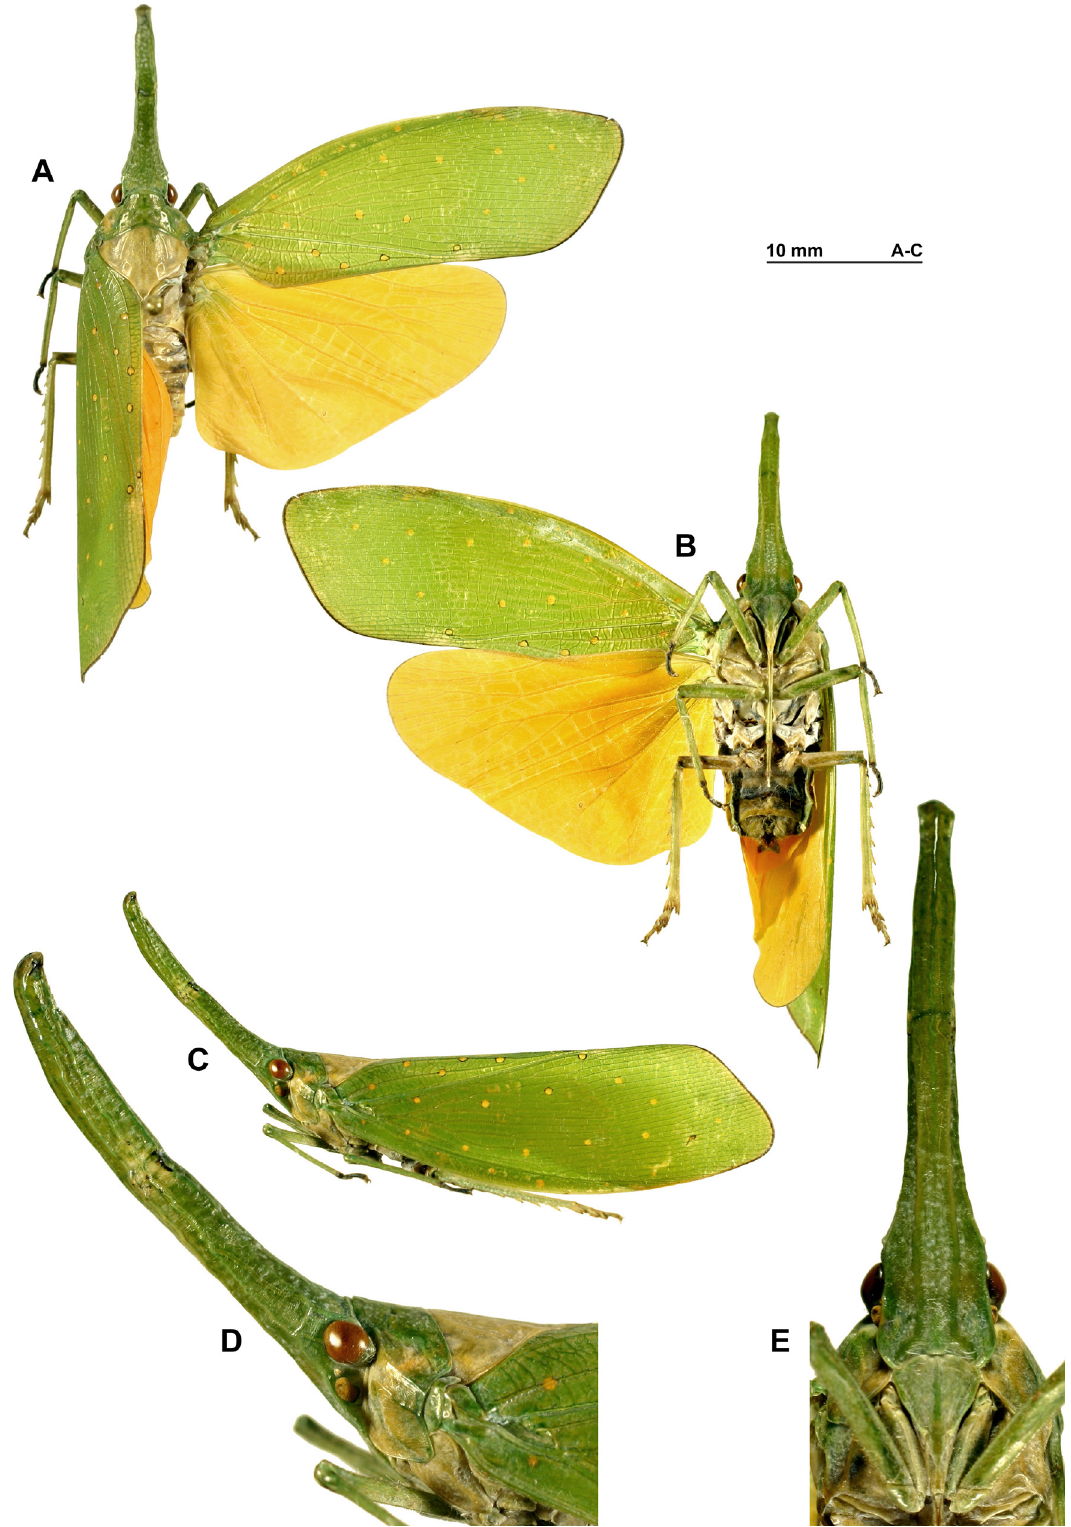
Fig. 13. Pyrops itoi (Satô & Nagai, 1994), ♀, Thailand, Khao Soi Dao Wildlife Sanctuary, May 2012 (RBINS). A . Habitus, dorsal view. B . Habitus, ventral view. C . Habitus, lateral view. D . Head and thorax, lateral view. E . Head, perpendicular view of frons. D–E = not to